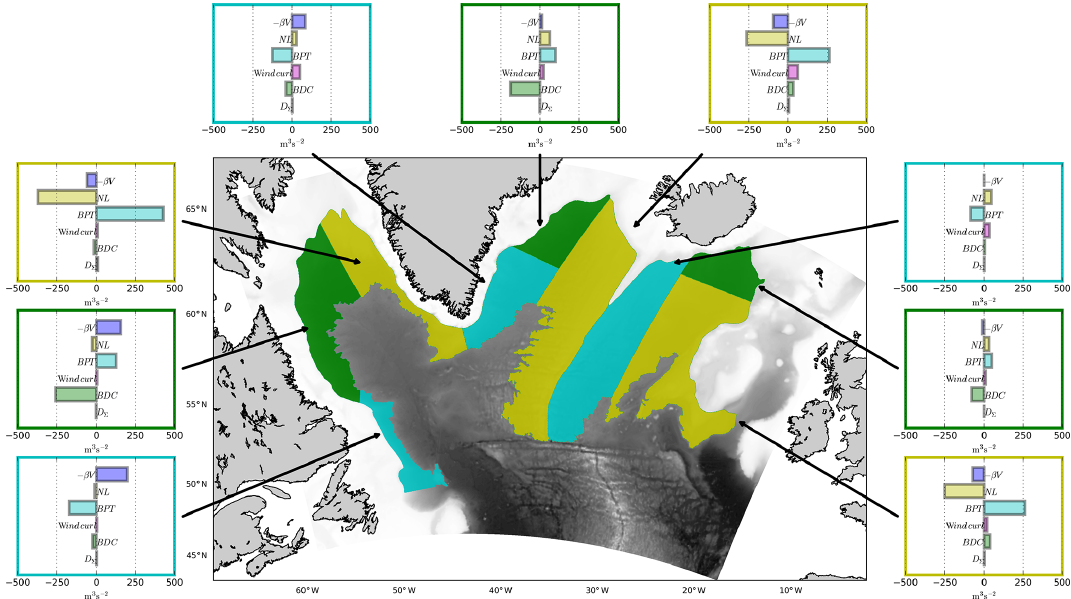
Figure 11. Barotropic vorticity balance integrated over different parts of the gyre along the slope.